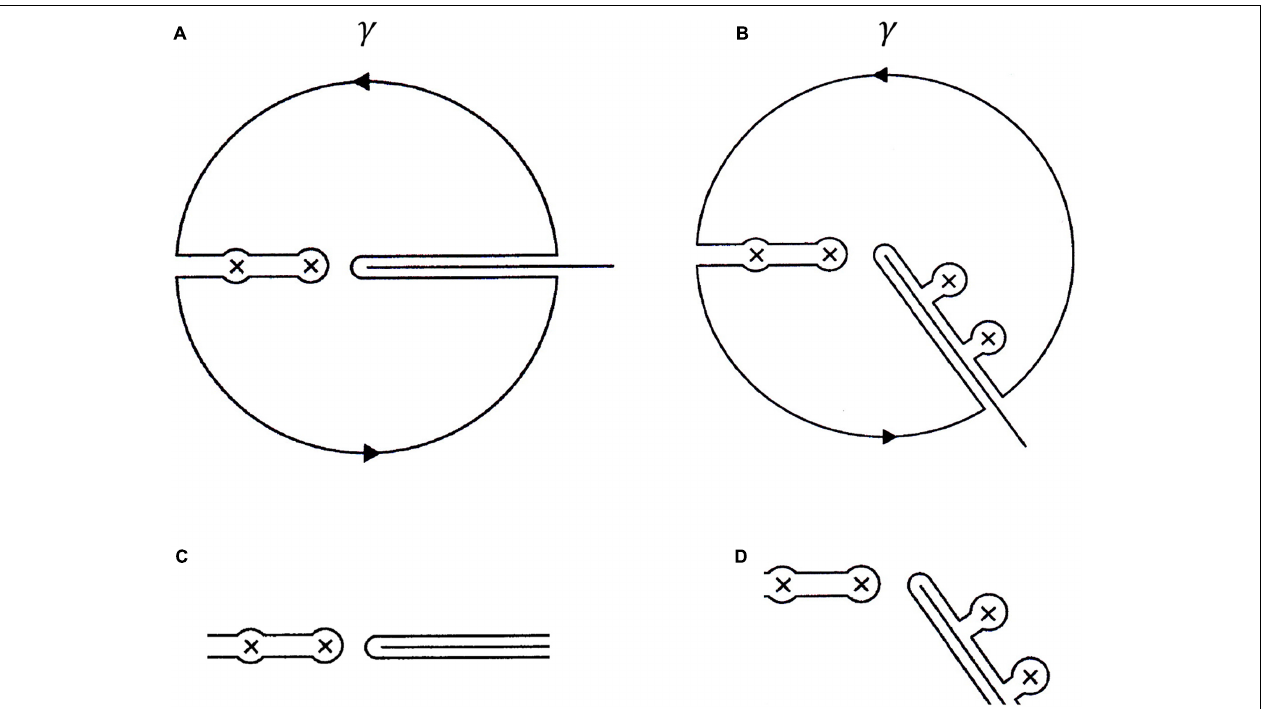
FIGURE 4 | The contour γ defining the Cauchy representation of f ( z ) in the case (A) referring to the situation displayed in Eqs. (7, 8) and in the case (B) after analytic continuation. The excluded regions, (C,D) are adapted after the spectral domains in each case.